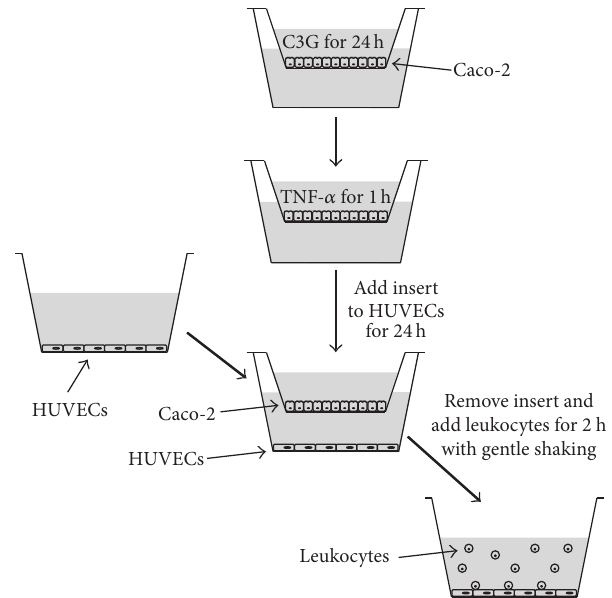
Figure 1: Schematic diagram of coculture assay of differentiated Caco-2 cells and HUVECs and human leukocyte and